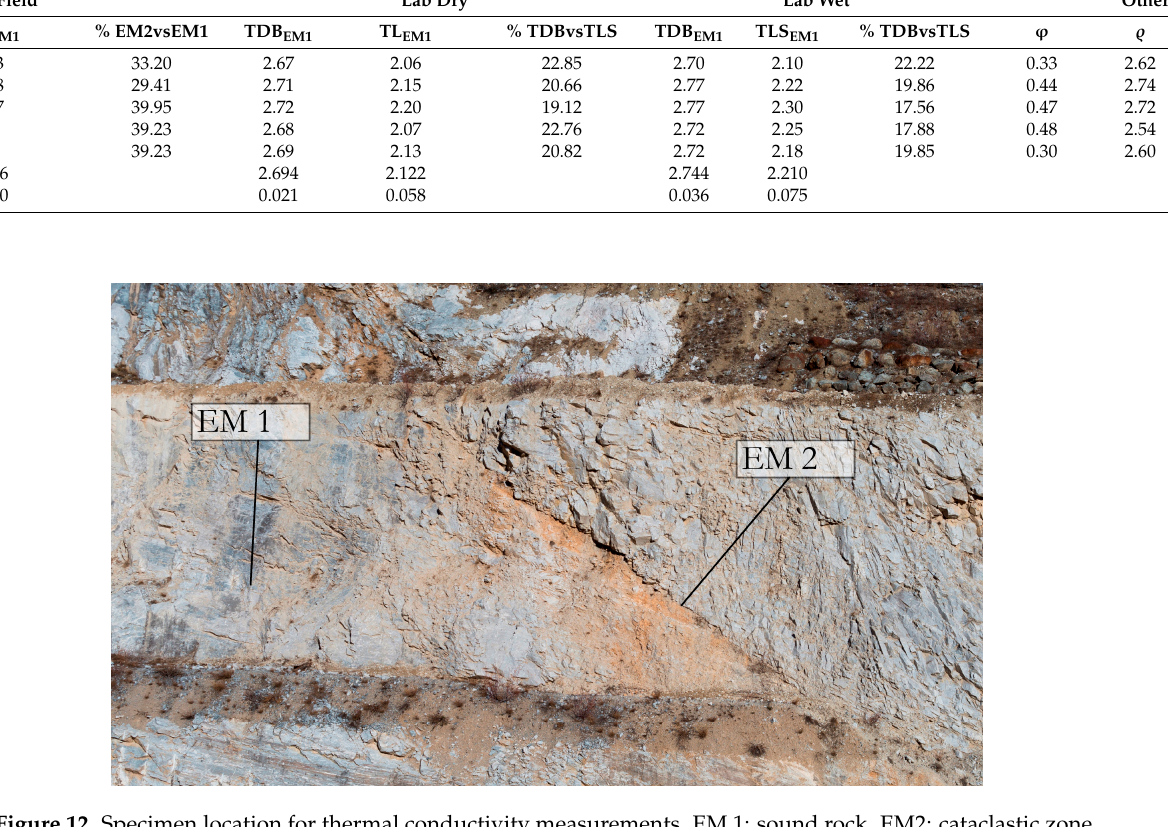
Figure 12. Specimen location for thermal conductivity measurements. EM 1: sound rock. EM2: cataclastic zone.